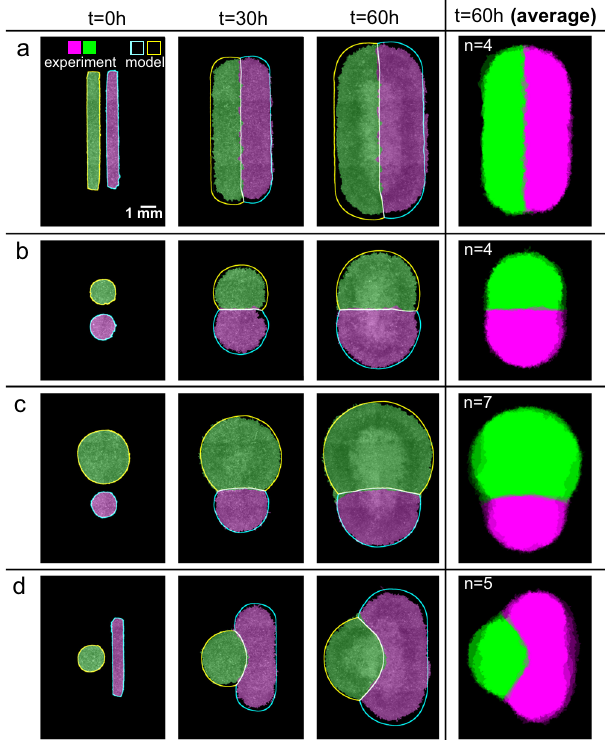
Fig. 1 The shapes of colliding tissues are stereotyped and predictable. a – d Archetypal collision experiments (solid) and simulations (outline) for equally sized rectangles ( a ), equally sized circles ( b ), size-mismatched circles ( c ), and circle-rectangle pairs ( d ). Averages over several tissues at 60 h are shown in the rightmost panels ( n = 4 – 7). See Supplementary Videos 1 and